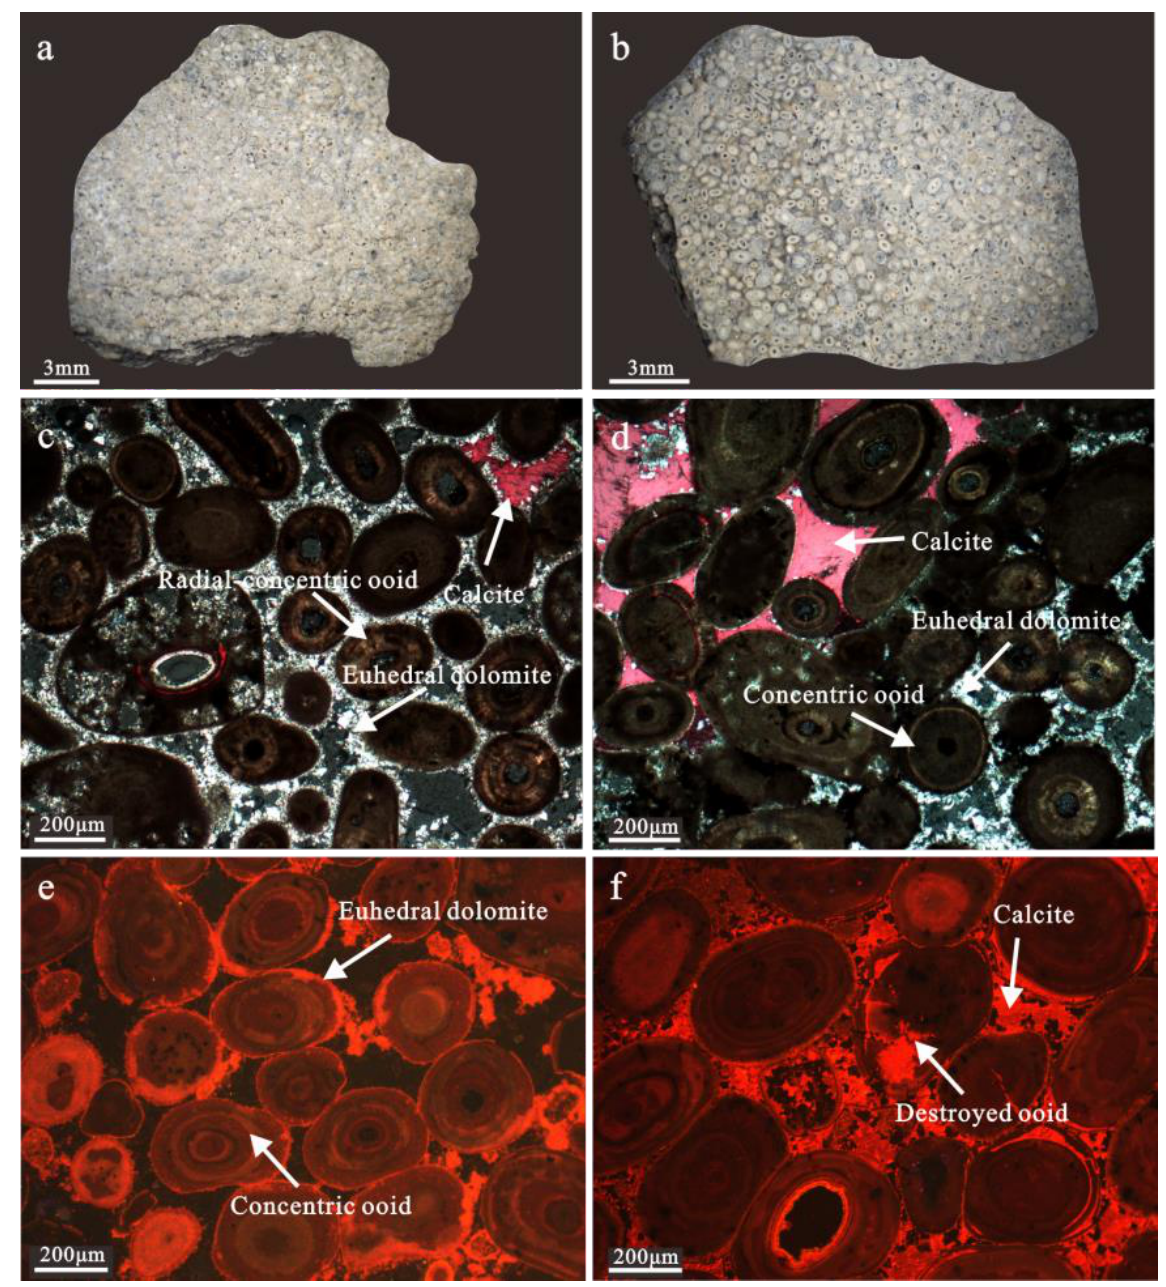
Figure 4. Hand sample Z1-15 and photomicrographs of the sample. ( a ) Photograph of the hand sample Z1-15, which consists of well sorted ooids; ( b ) stereoscopic photograph of the thin section of gray-white ooids; ( c , d ) cross-polarized-light images of the ooids show spherical or ovoid shapes for ooids; ( e , f ) CL images reveal concentric dark and orange luminescence for ooids and light orange for calcite cement.